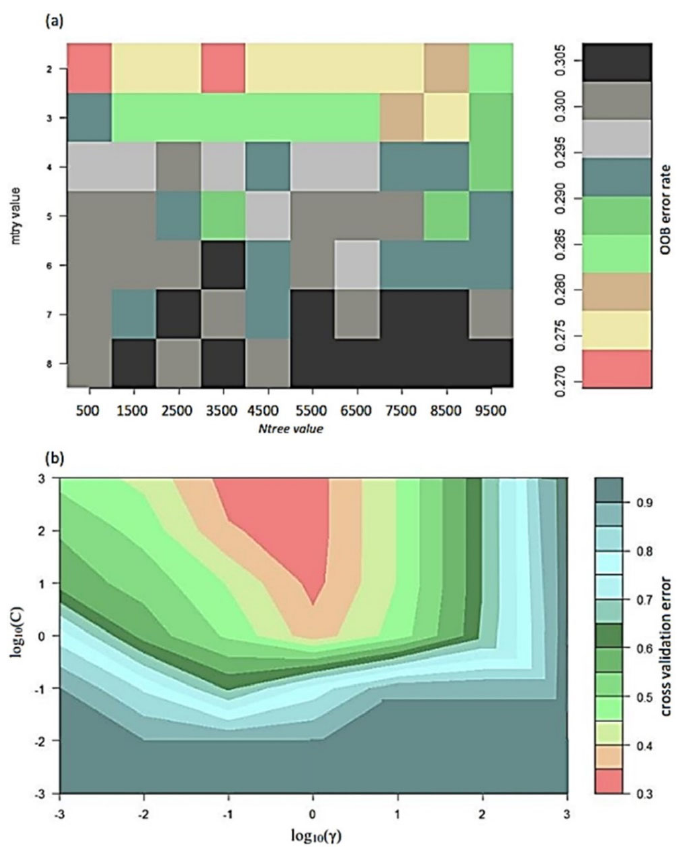
Figure 5. Optimization by 10—fold cross—validation: ( a ) random forest parameters ( mtry and ntree ), and ( b ) support vector machine parameters (gamma and cost).